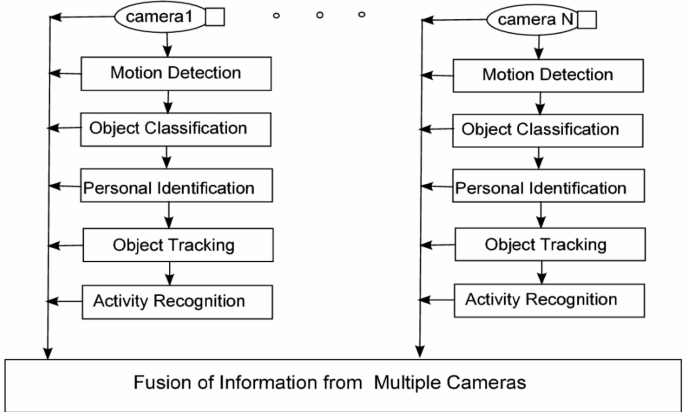
Figure 1. Weiming’s proposed framework for video surveillance [9].